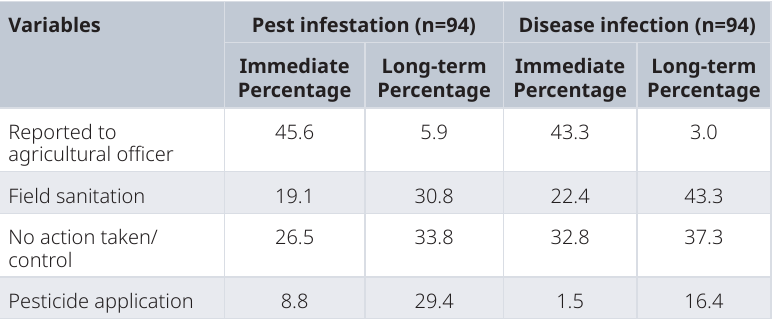
Table 9. Distribution of immediate action taken by farmers in pest and disease management.